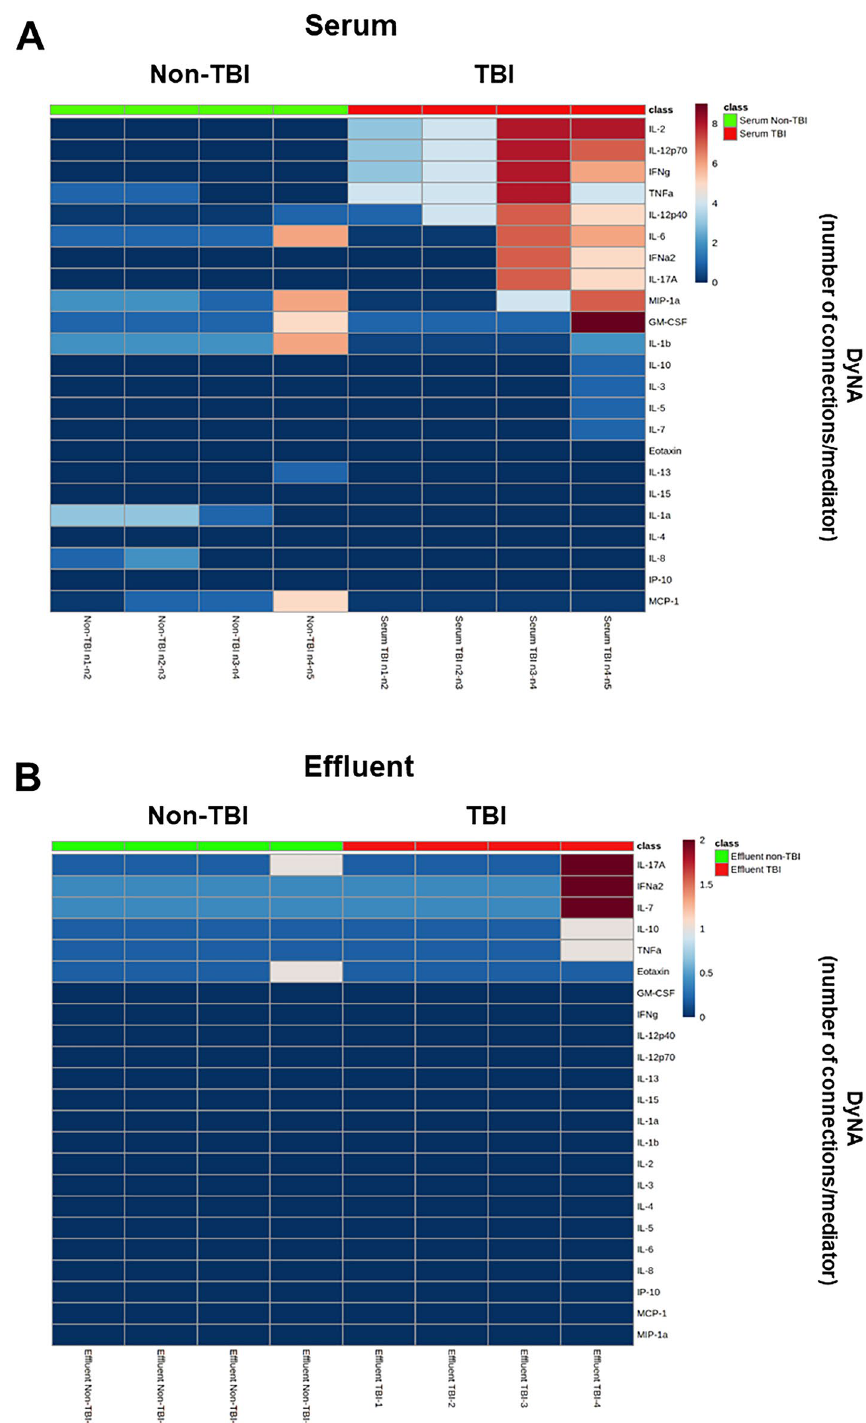
Figure 3. Dynamic Network Analysis (DyNA) of circulating inflammatory mediators TBI vs. non-TBI trauma patients. Circulating inflammatory mediators in serum and effluent samples from 59 TBI and 81 non-TBI patients were measured, and DyNA (stringency level = 0.95) was performed during each of four debridement intervals (n1-n2, n2-n3, n3-n4, n4-n5) using MATLAB® software as described for Fig. 2. Figure represents the specific number of connections/mediator and debridement interval in TBI vs. non-TBI patients shown as a heatmap (serum [ A ] and effluent [ B ]) using MetaboAnalyst 5.0 (https:// www. metab oanal yst. ca) and calculated as described in “Materials and